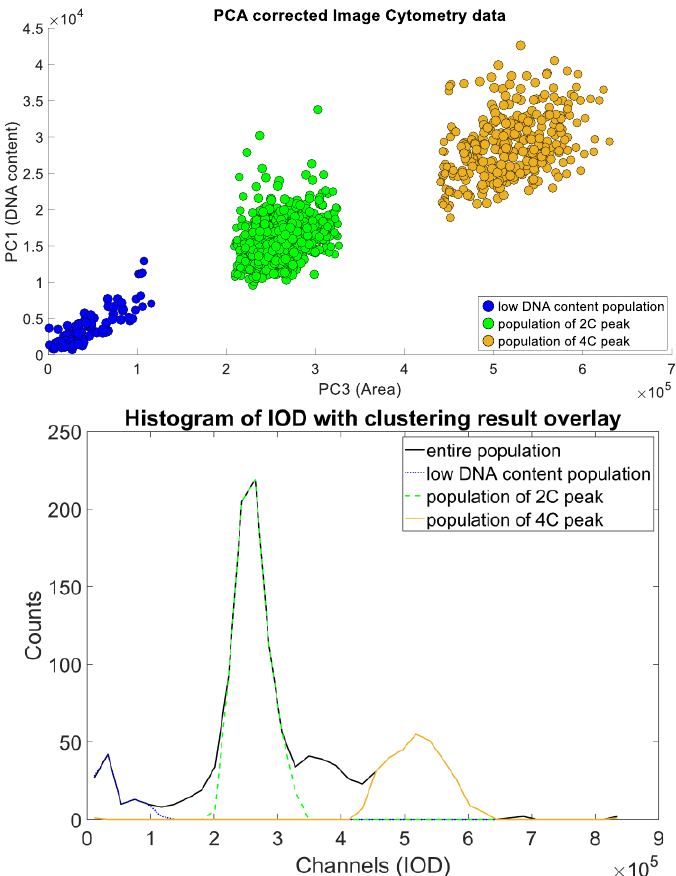
Figure 8. The results of c-means clustering on a single sample, with the clusters projected back to the DNA content distribution of the sample (blue, green, orange). These measurements were used to identify the approximate locations of the subpopulations of the 2N and 4N peaks.